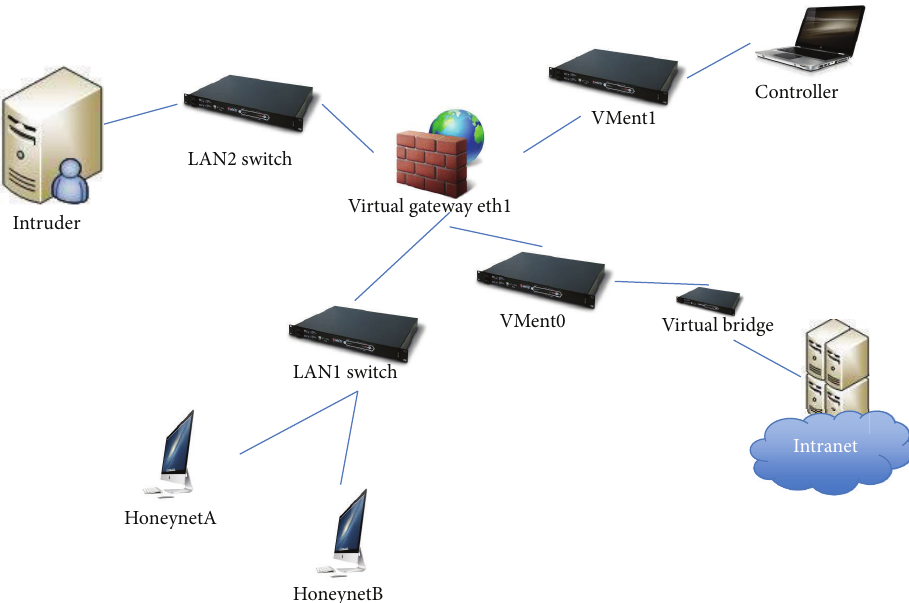
Figure 3: Membership function of the various